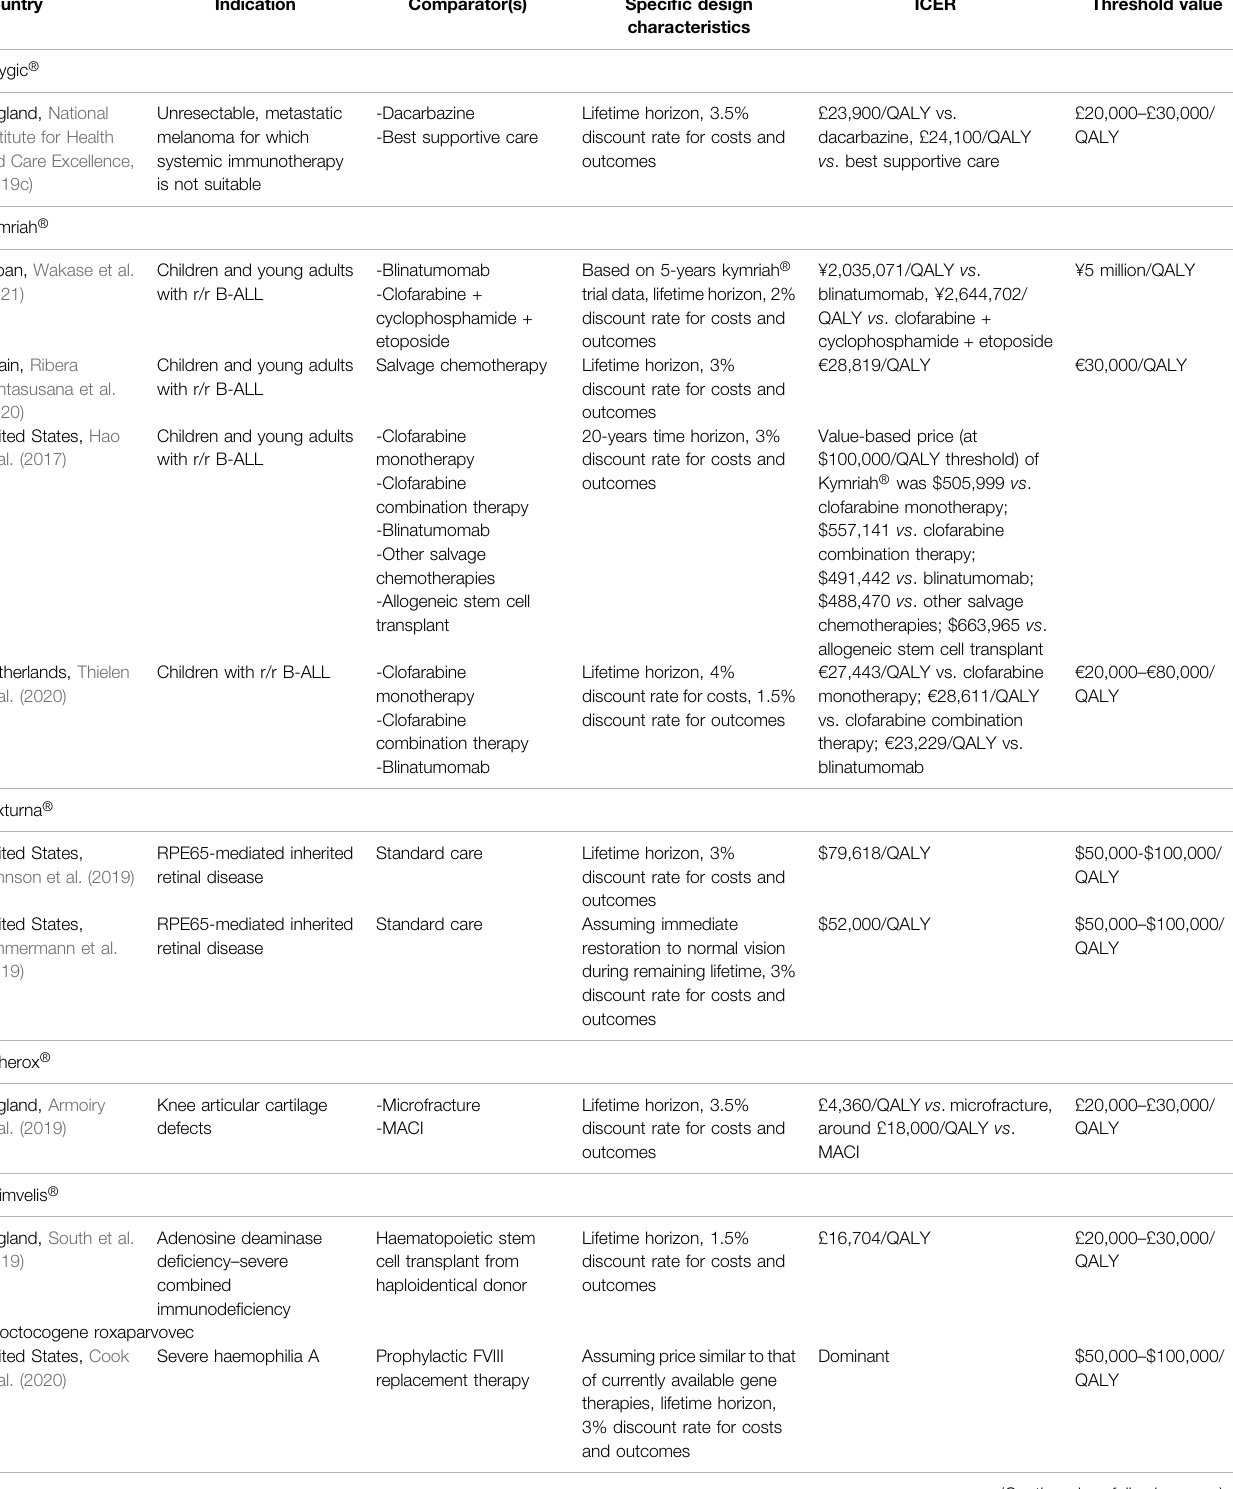
TABLE 1 | Examples of cost-effective advanced therapies based on economic evaluation from payer perspective.